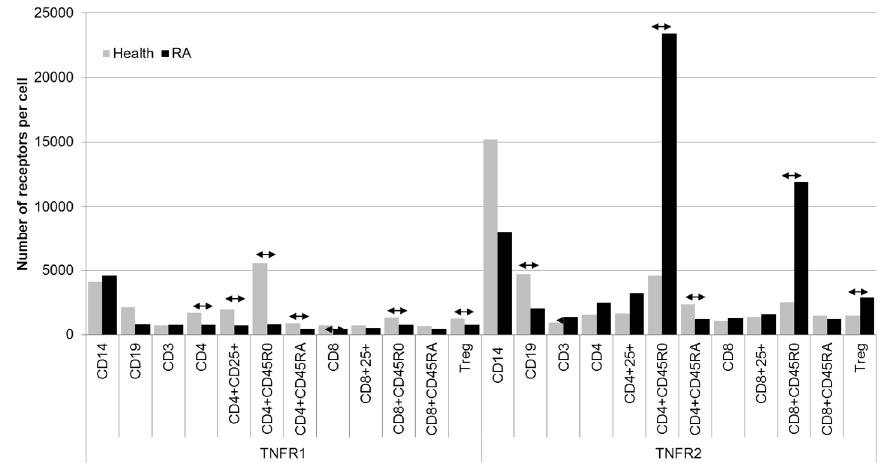
Figure 4. Number of type 1 and 2 receptors for TNF α on the surfaces of immune cells. Data are presented as median. Arrows indicate statistically significant differences ( p < 0.05). Table 1. Number of type 1 and 2 receptors for TNF α on the surfaces of immune cells. Data are presented as median and interquartile range.